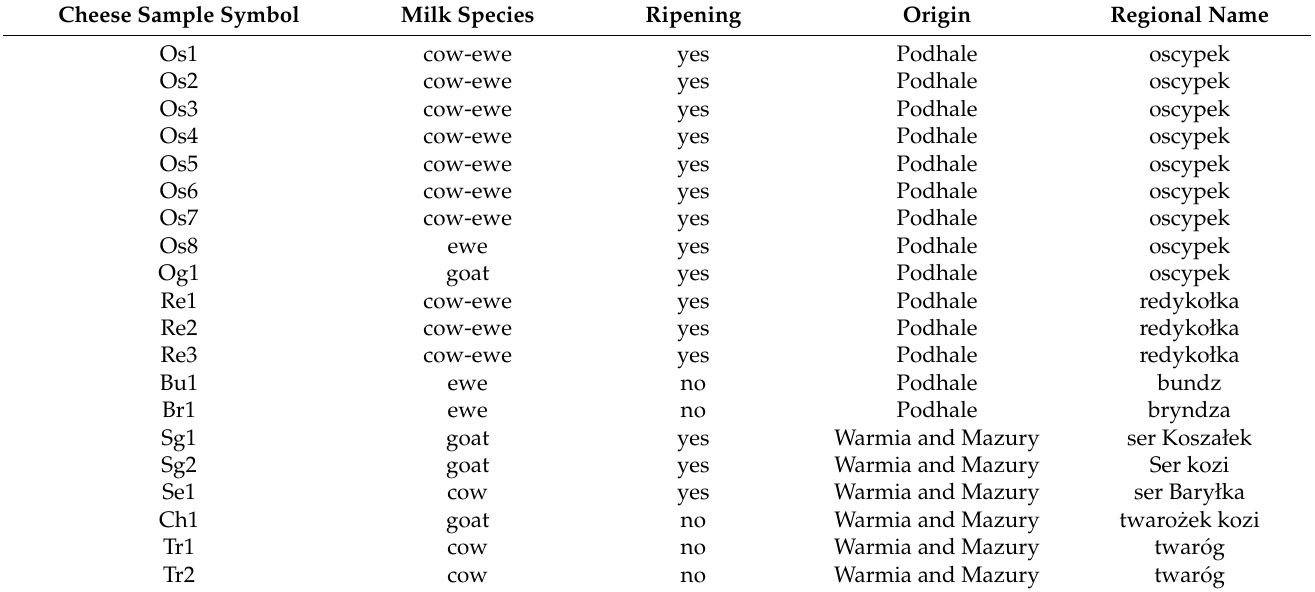
Table 1. Characteristics of studied cheeses. Cheese Sample Symbol Milk Species Ripening